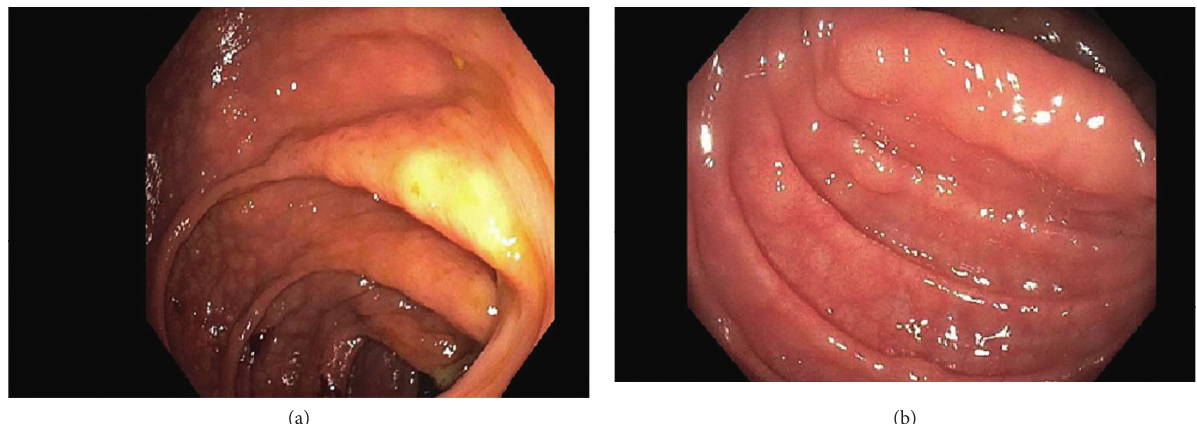
Figure 1: Colonoscopy showing submucosal